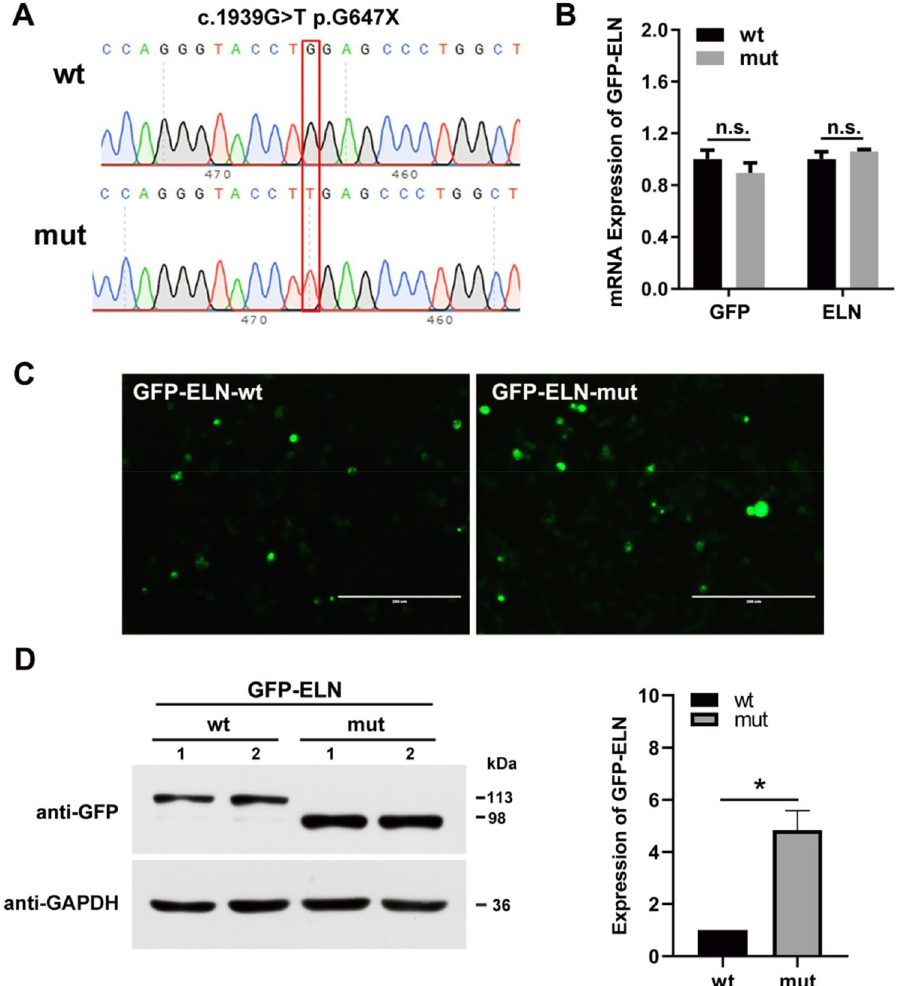
Figure 4. The mutation site (NM_001278939.1: c.1939G>T, p.Gly647Ter) affects ELN expression. ( A ) The pEGFP-ELN-wt/mut sites as showed through Sanger sequencing. ( B ) ELN mRNA levels before and after mutation. ( C ) Micrographs of fluorescence microscope images of ELN in 293 T. Scale bar, 200 µm. ELN was stained with green, the nucleus with blue (N = 3). ( D ) Immunoblot of GFP protein levels and quantification of ELN relative protein levels in 293 T. GAPDH served as loading control. Values are means ± SEM. * P < 0.05, ** P < 0.01 was considered significant (N =